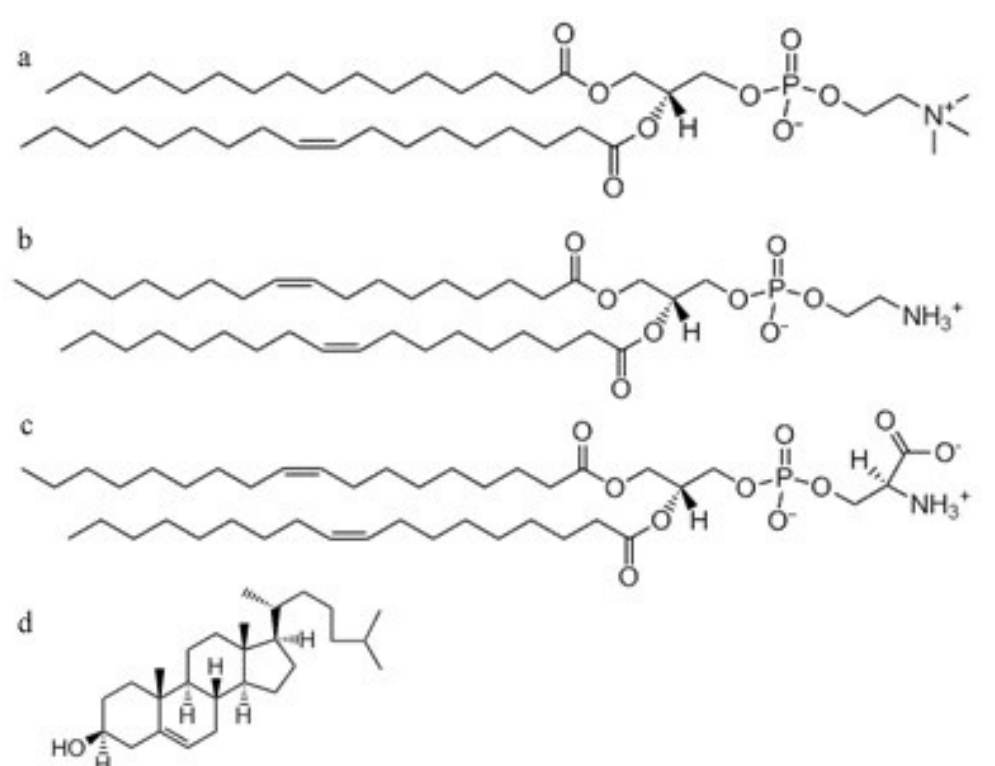
Membranes 2021 , 11 , 132 Figure 2. Molecular structures of ( a ) palmitoyl-oleoyl-phosphatidylcholine (POPC), ( b ) dioleoyl-phosphatidylethanolamine (DOPE), ( c ) dioleoyl-phosphatidylserine (DOPS), ( d ) and Cholesterol (Ch).